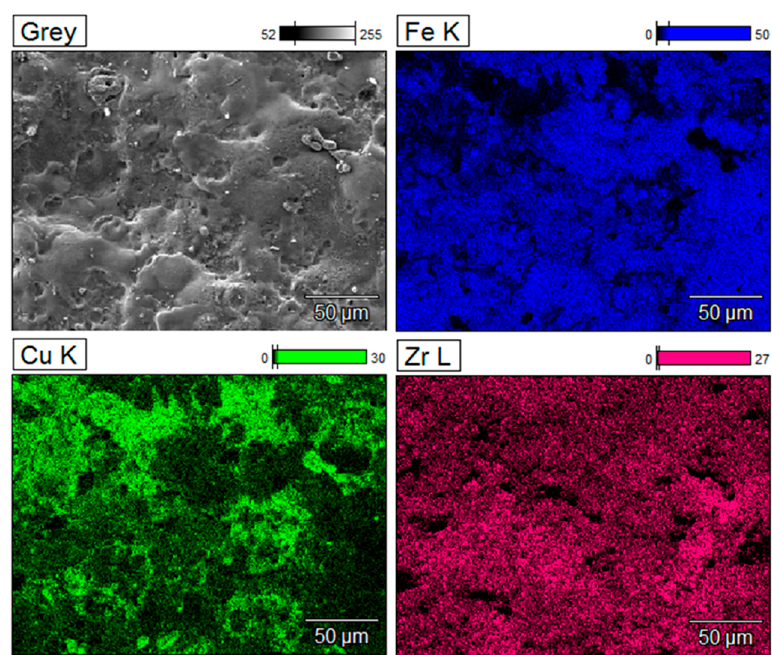
Figure 4. SEM micrograph and EDS spectrum of machined surface for Ip = 5 A and Ton = 25 μ s.